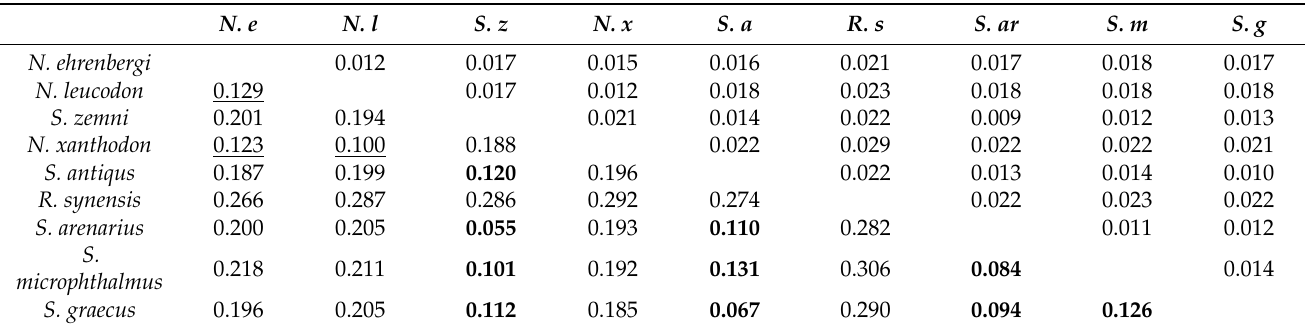
Table 5. Estimates of evolutionary divergence over sequence pairs inferred from the MT-CYTB dataset between three Nannospalax superspecies and the